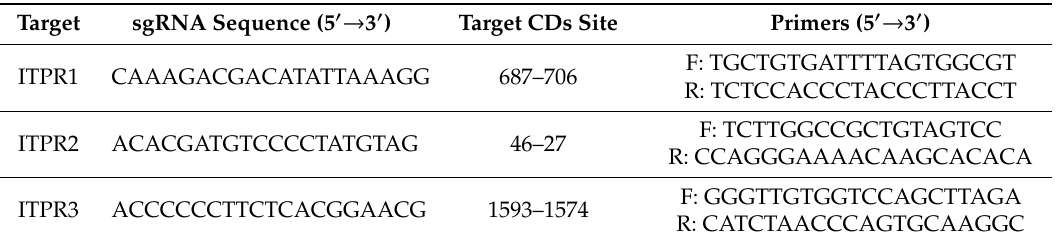
Table 1. Sequences of sgRNAs and sequencing primers used for knocking out IP 3 Rs in HEK293 cells.